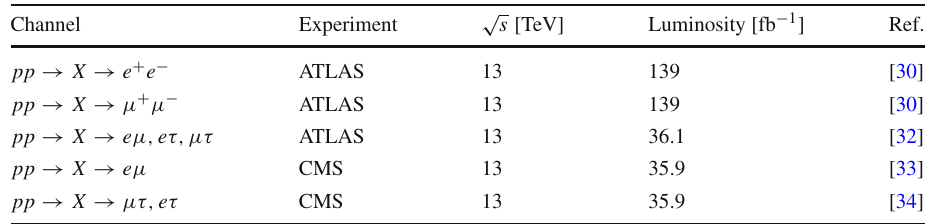
Table 2 List of experimental searches for BSM resonances decaying into a di-jet final states newly implemented into HiggsBounds